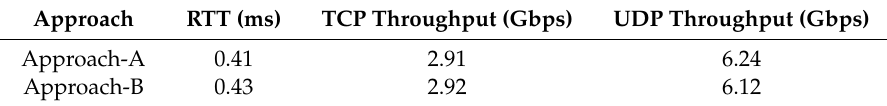
Table 3. The measured numbers of RTT Netperf TCP_STREAM and Netperf UDP_CRR.